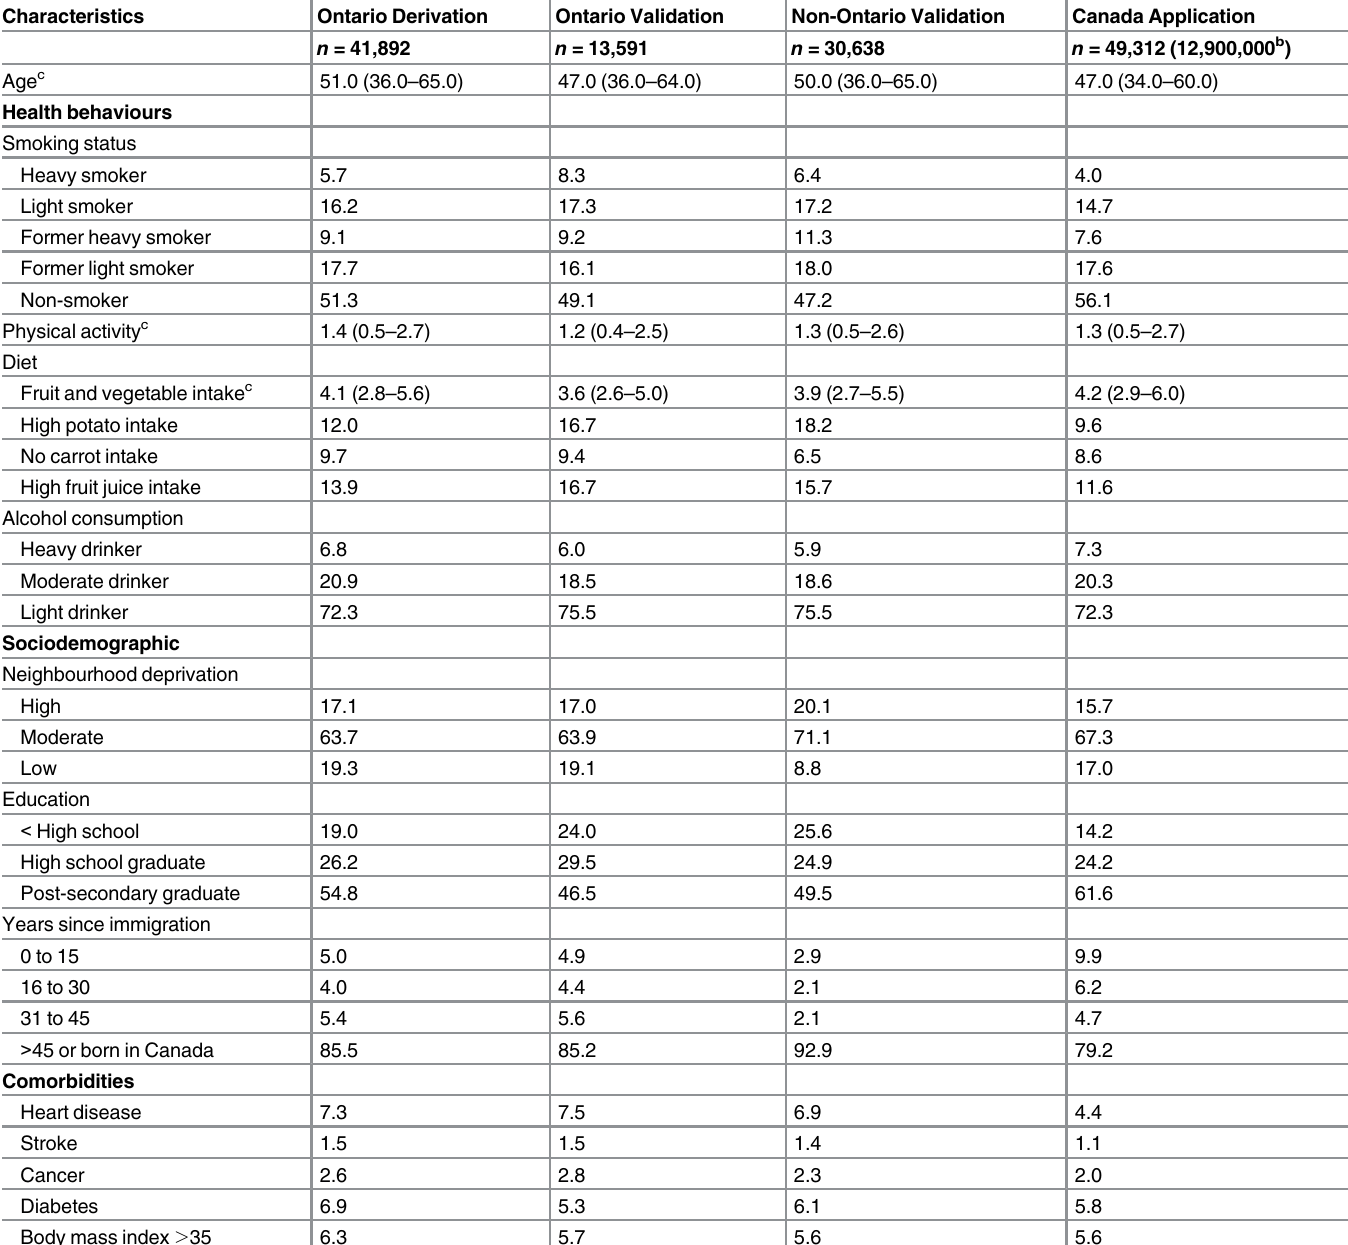
Table 3. Baseline characteristics of female study cohorts. a